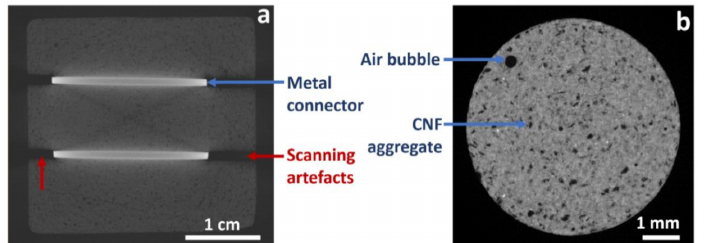
Figure 3. X-ray tomography cross section through the specimen with indicated metal connectors, and scanning artefacts originating from beam hardening effect ( a ) and sample of the same cement materials scanned at higher resolution ( b ).